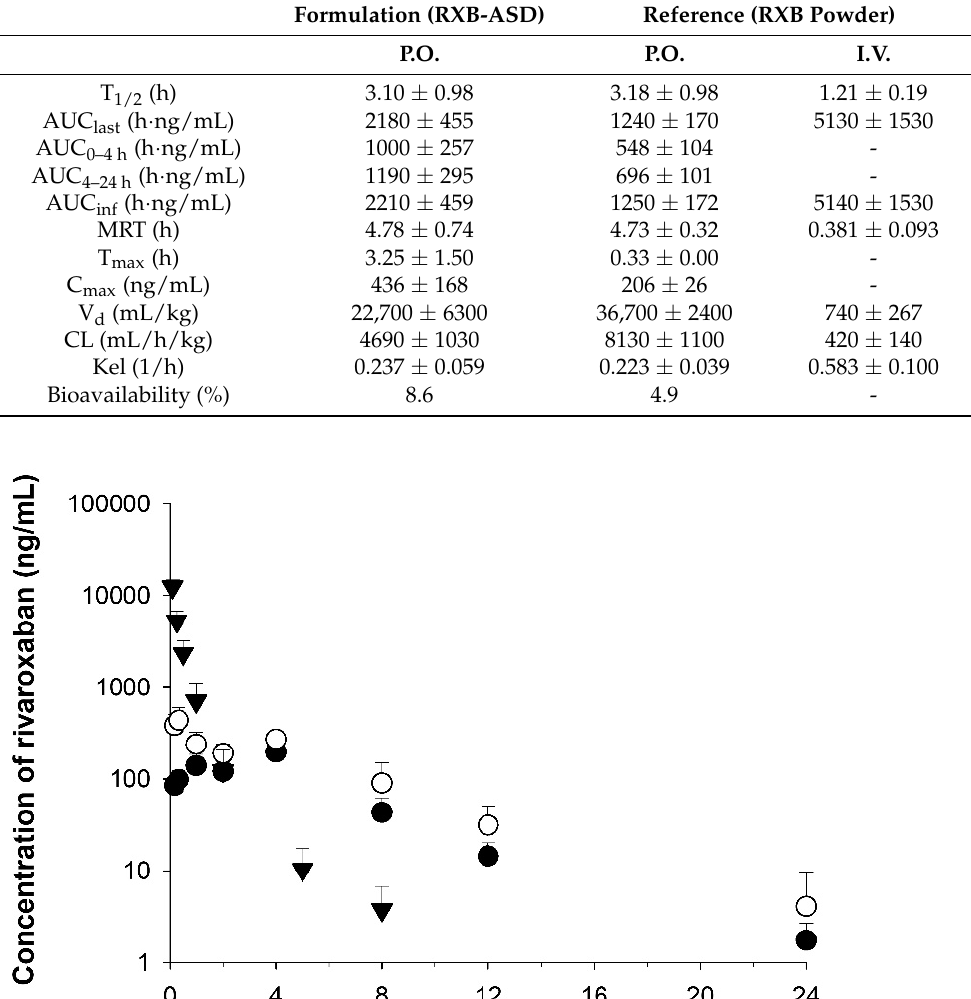
Table 6. Pharmacokinetic parameters of optimized RXB-ASD and raw RXB powder in rats after intravenous administration of 2 mg/kg and oral administration of 10 mg/kg. Data are shown as the mean ± SD ( n = 4). Formulation (RXB-ASD) Reference (RXB Powder) P.O.